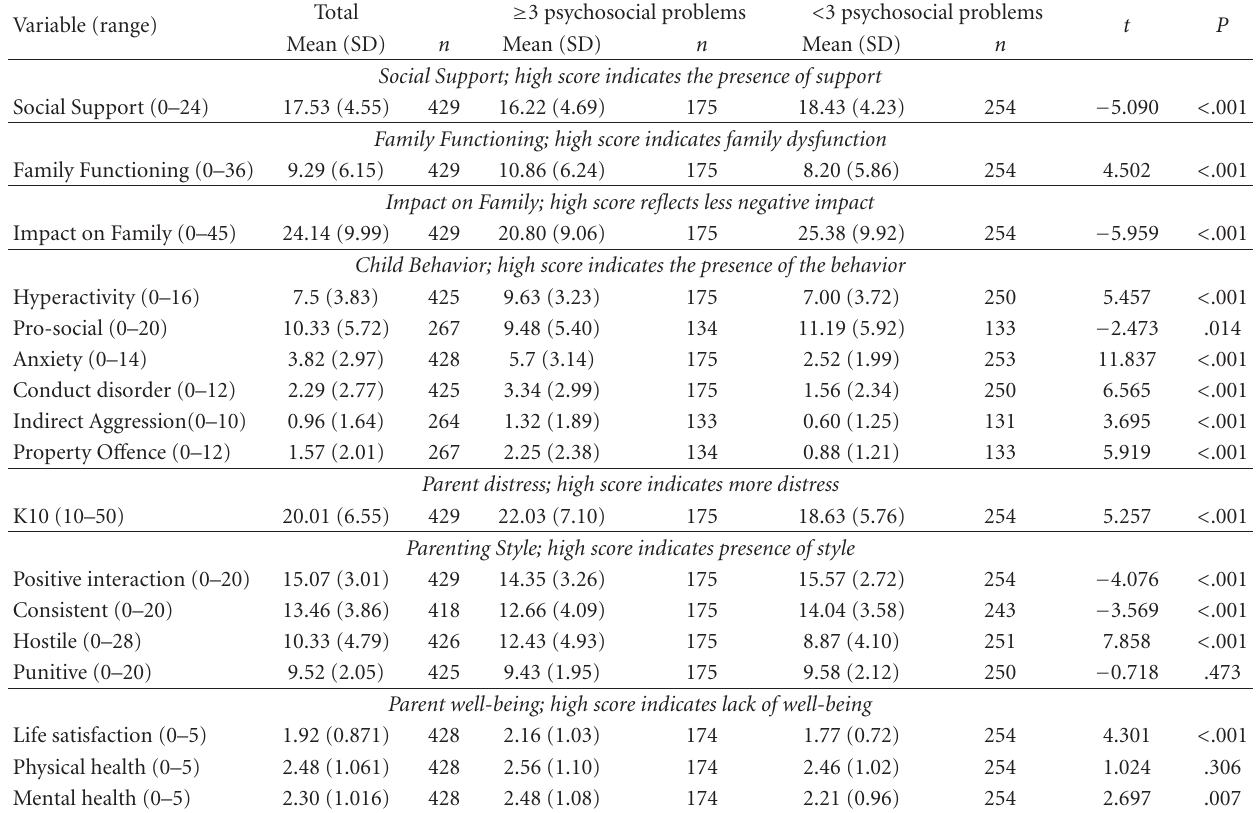
Table 6: Family and child variables by Psychosocial Quality of